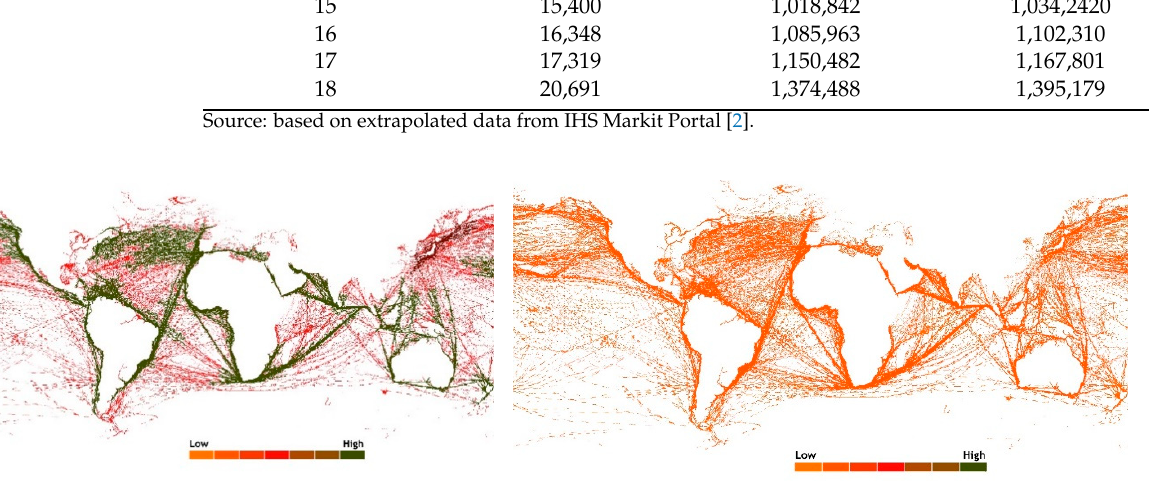
Table 8. Estimated amount of NO x emissions generated by container shipping in